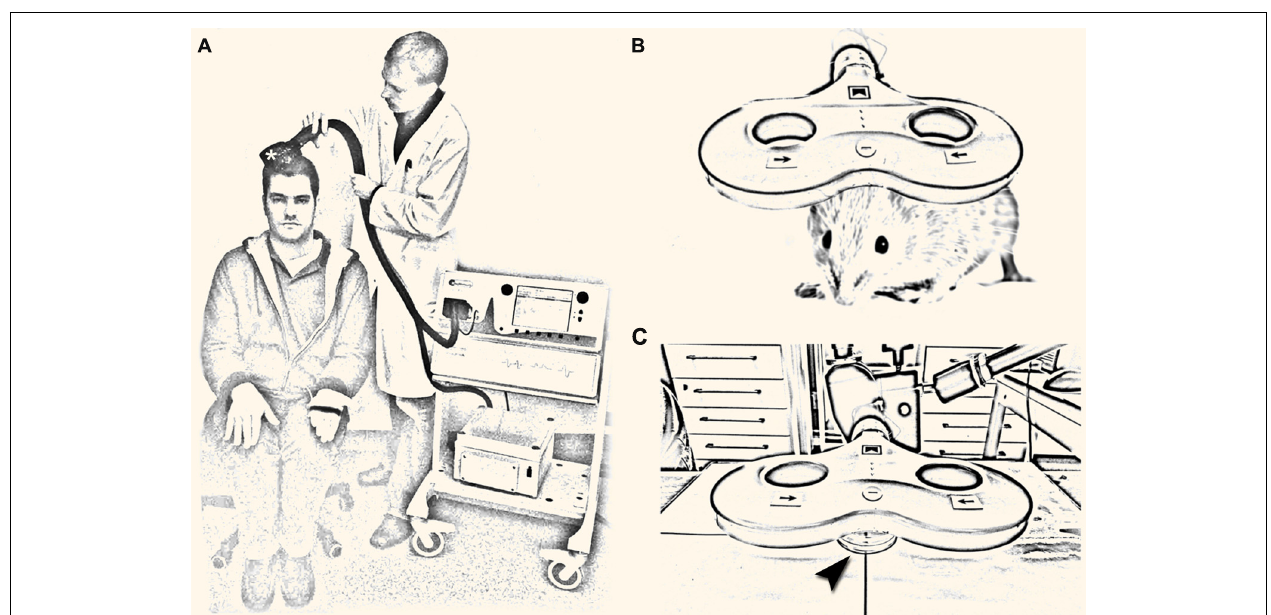
rTMS in neurological and neuropsychiatric diseases with abnormal cortical excitability [image shows the authors; a tribute to A. Barker; (Barker etal., 1985)]. (B,C) Repetitive magnetic stimulation (rMS) of small animals (B) and suitable in vitro preparations [arrowhead in (C) points at a Petri-dish] are urgently needed to unravel the cellular and molecular mechanisms of repetitive magnetic stimulation, which remain not well